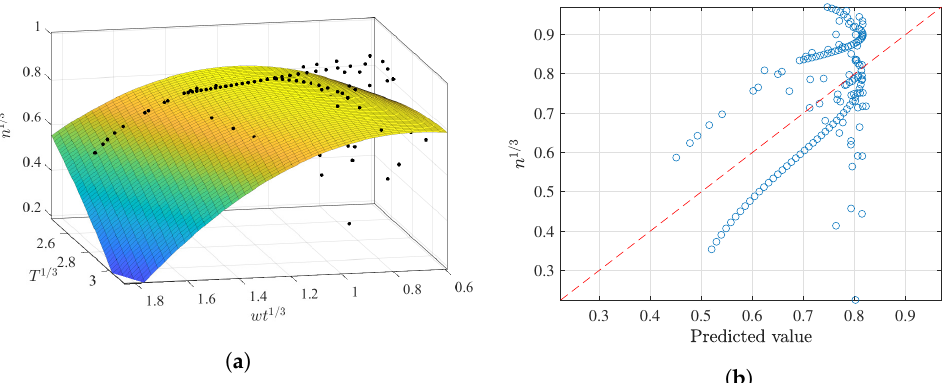
Figure 15. Best polynomial regression result of n in terms of wt and T for the AS dataset: ( a ) fitting results; ( b ) prediction capabilities.